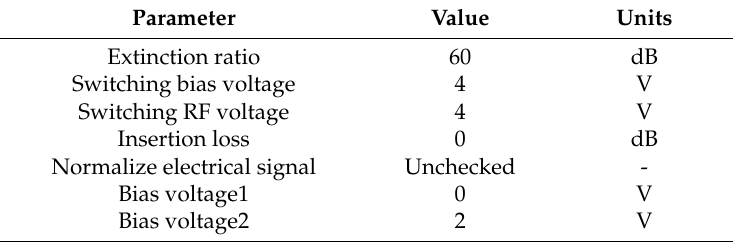
Figure 13. OptiSystem simulation system to validate irregular θ performance in overcoming DPF, ( a ) RoF link with ODSB and OSSB modulations; ( b ) RoF system with an irregular θ for scheme C2; and ( c ) scheme C4. Table 5. Setting parameter of